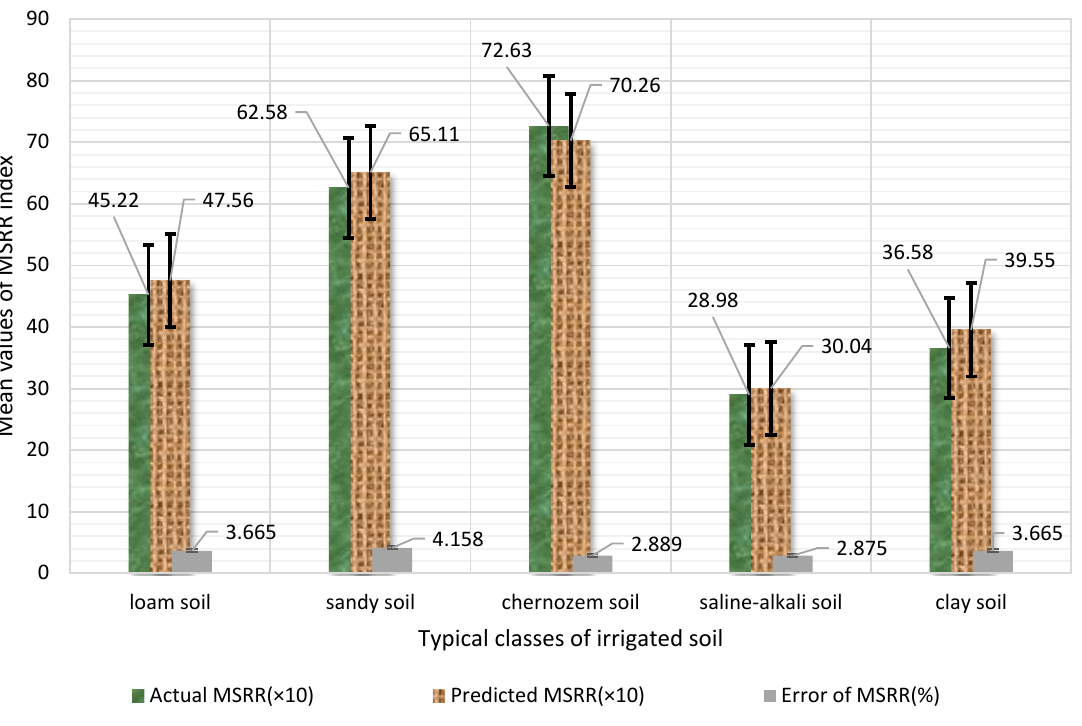
Figure 19. Comparison between the actual and predicted MSRR values in typical soil types.